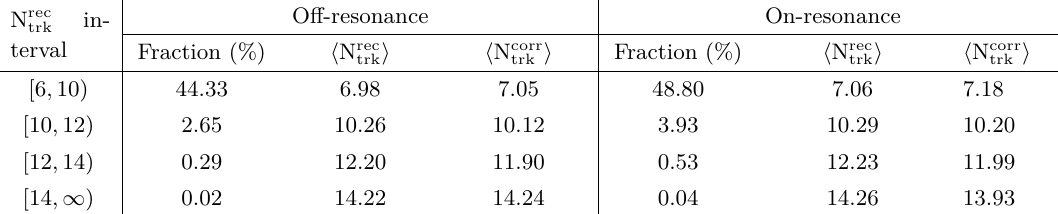
Table 2. Average multiplicities and corrected multiplicities with high-quality tracks for different N rec intervals for the off-resonance and on-resonance datasets. These tracks pass requirements in trk table 1: p 0 . 2 GeV/ c and 17 ◦ ≤ θ ≤ 150 ◦ , hence the high T ≥